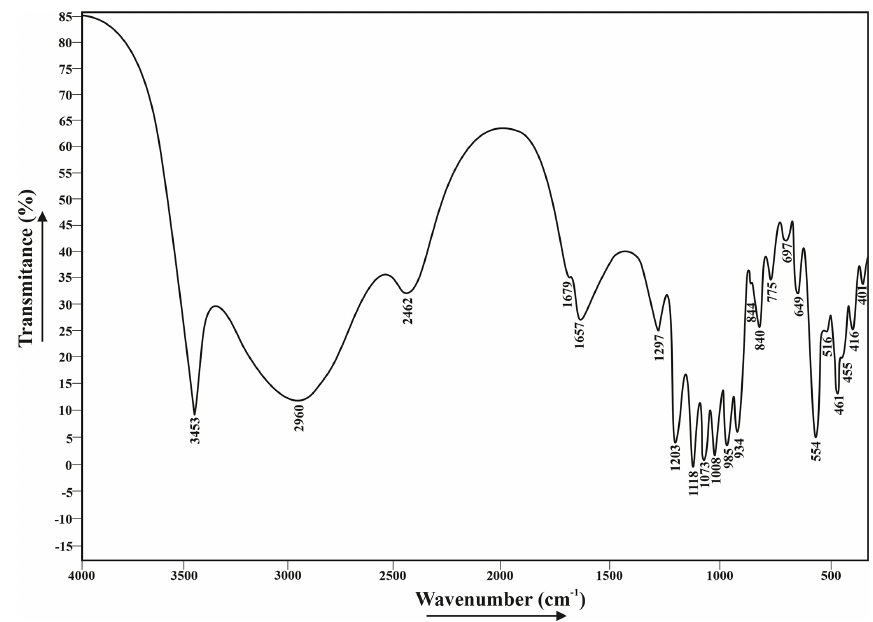
Figure 4. Infrared spectrum of francoanellite from Gura Dobrogei